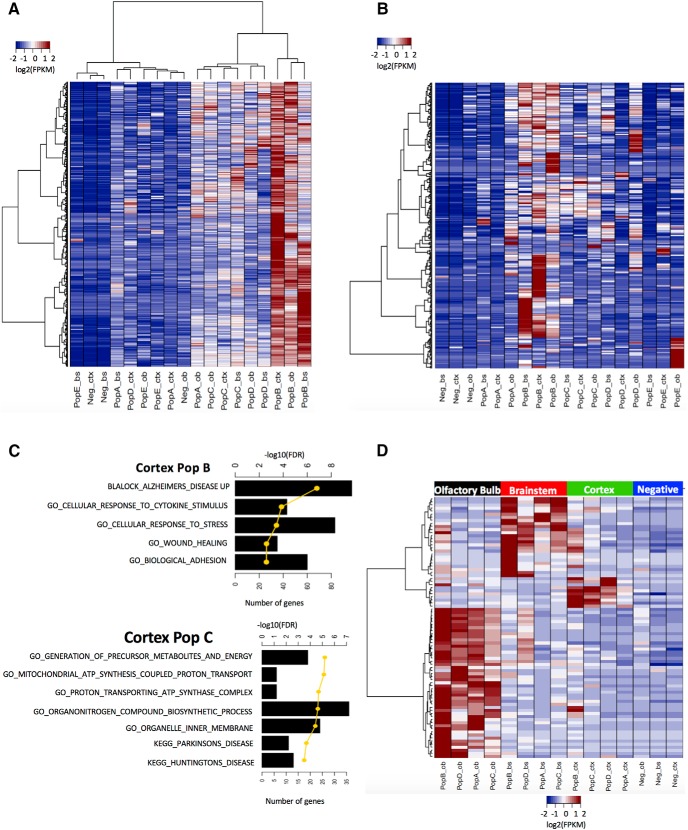
Gene signatures defined by astrocyte subpopulations and brain regions. A, Heatmap showing the log2-transformed FPKM values of cortex subpopulation B-enriched genes (protein-coding and lncRNAs) compared with other subpopulations. DE genes were obtained by performing pairwise comparisons of astrocyte subpopulations in each brain region to their corresponding non-astrocyte samples. Selection criteria: FPKM > 1, fold-change > 2, and FDR < 10%. B, Heatmap illustrating upregulated DE lncRNA genes from astrocyte regional subpopulation gene signatures. C, The top five significantly enriched gene sets obtained using the gene signatures of cortex subpopulation B (top) and cortex subpopulation C (bottom). Bar plots indicate the number of genes found in the enriched gene set. The yellow line illustrates the gene set enrichment using -log10-transformed FDR. D, Heatmap depicting the region-specific astrocyte gene signatures. DE genes were obtained by comparing all samples from the same brain region to the remaining regions (FPKM > 1, fold-change > 4, and p < 0.05) and to their corresponding non-astrocyte samples (FPKM > 1, fold-change > 2, and p < 0.05). Colors of all heatmaps represent log2 transformed FPKM values. See also Extended data Figures 2-1, 2-2, 2-3, 2-4.